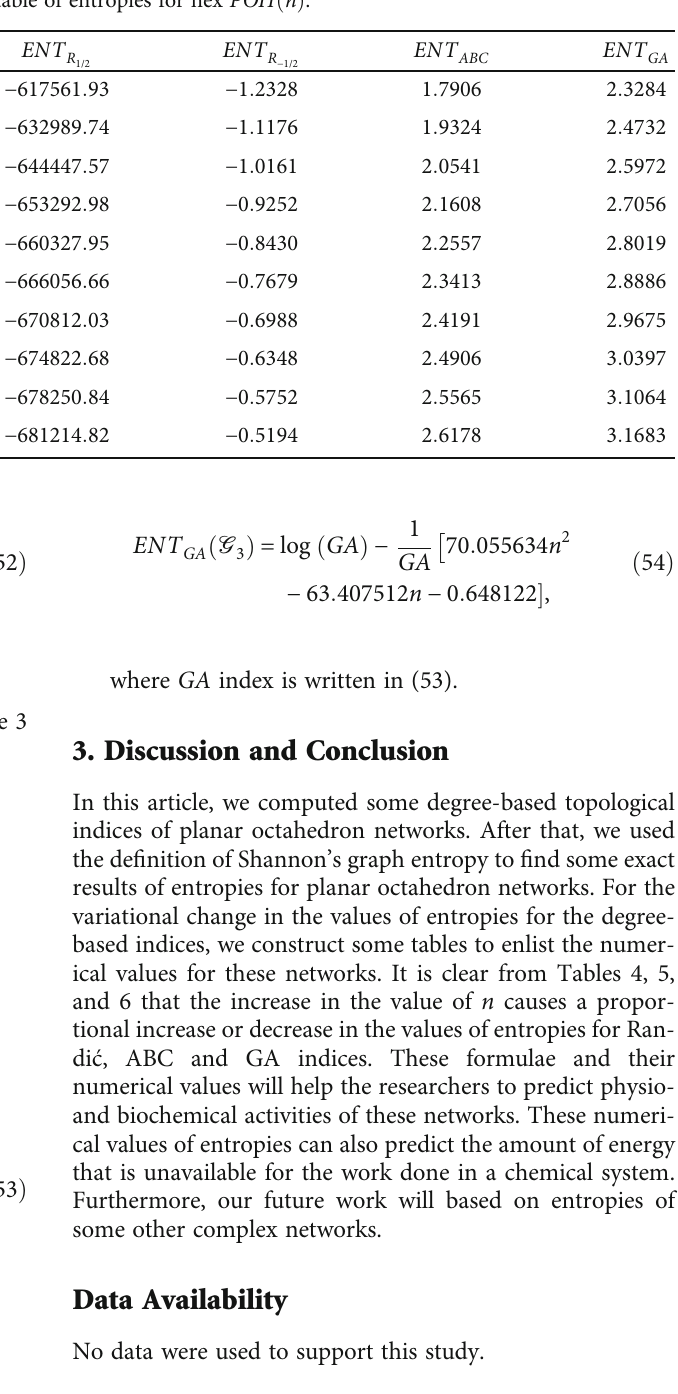
Table 6: Comparison table of entropies for hex POH ð n Þ